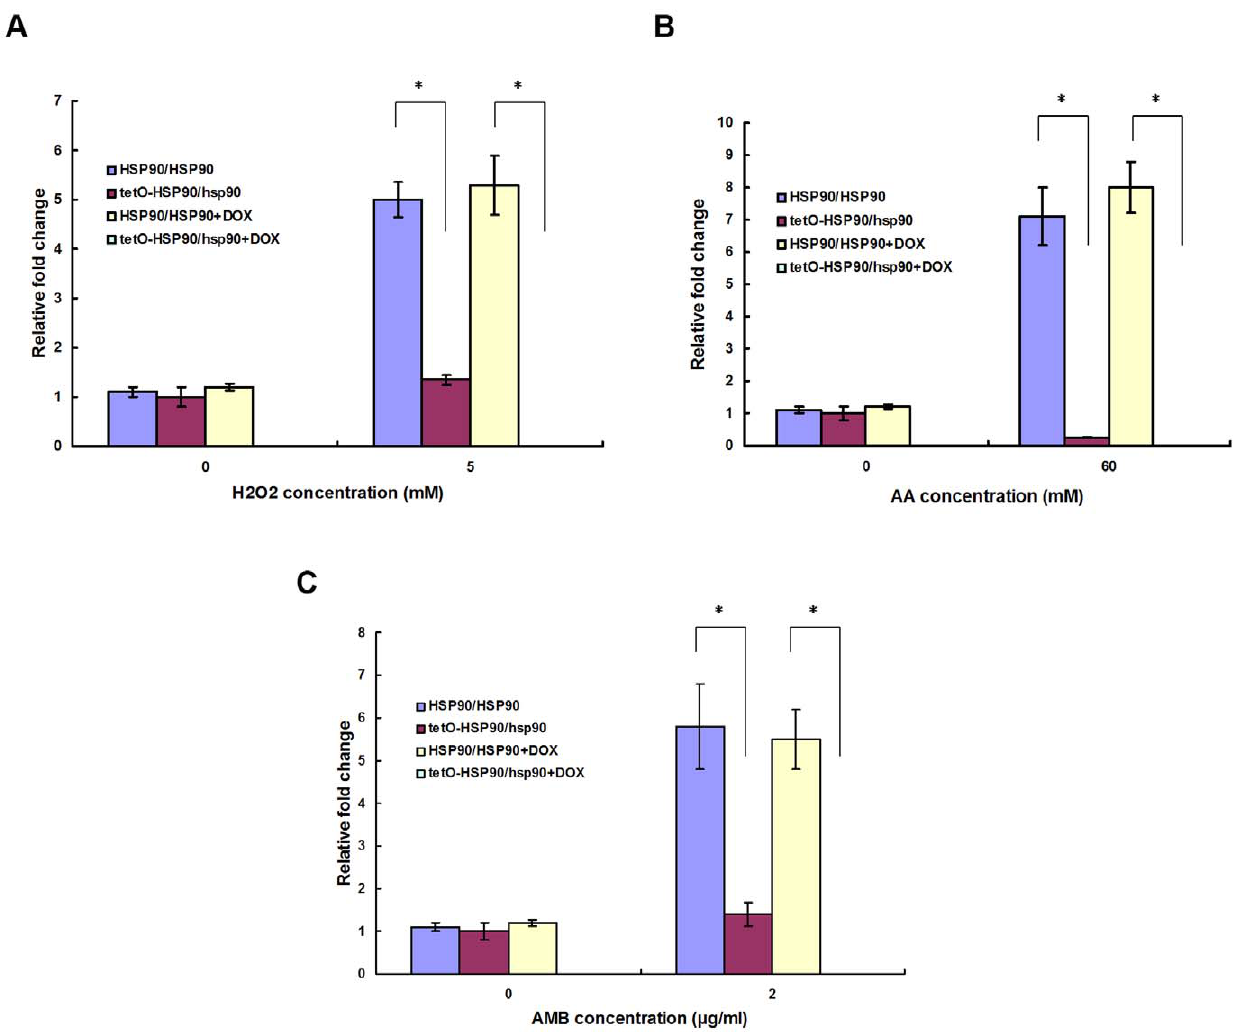
Figure 1. HSP90 expression after apoptotic stimulus treatment. C. albicans cells were treated with or without apoptotic stimuli for 3 h in the absence or presence of 20 m g/ml DOX. (A) Cells treated with H 2 O 2 . (B) Cells treated with AA. (C) Cells treated with AMB. Transcriptional level of HSP90 was detected through real-time RT-PCR and normalized on the basis of the 18S level. Data are shown as mean 6 SD from three independent